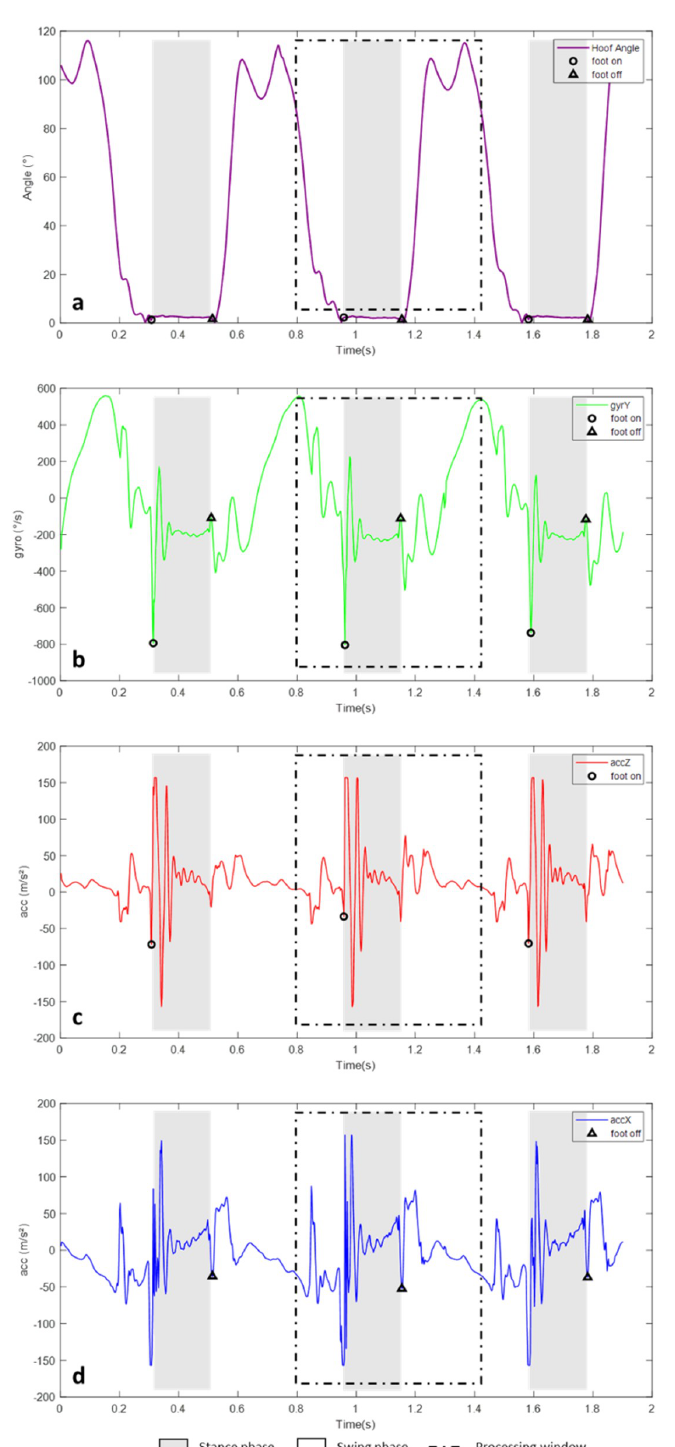
Figure 4. Representation of ( a ) the hoof angle calculated from the hoof markers allowing the detection of Foot on (o) and Foot off ( ∆ ) reference events ( MoCapFootOn and MoCapFootOff ), ( b ) the Y‐axis gyroscopic signal used for the detection of Foot on (o) and Foot off ( ∆ ) events in method A ( ImuFootOn_A and ImuFootOff_A ) and method C ( ImuFootOn_C and ImuFootOff_C ), ( c ) the Z‐axis accelerometric signal used for detection of Foot on (o) events in method B ( ImuFootOn_B ) and method D ( ImuFootOn_D ), ( d ) the X‐axis accelerometric signal used for detection of Foot off ( ∆ ) events in method B ( ImuFootOff_B ) and method D ( ImuFootOff_D ).